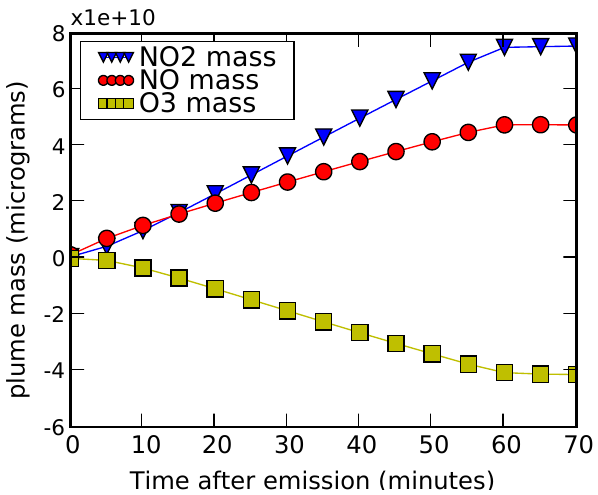
Fig. 2. Vertical profile as a function of time: difference between O 3 concentrations averaged over the simulation domain (in µgm − 3 ) with and without the subgrid treatment. Simulation with one point source of NO x in a uniform background of O 3 . The dashed lines represent the vertical levels interfaces of the Eulerian model. The vertical levels are indicated in meters above the ground.